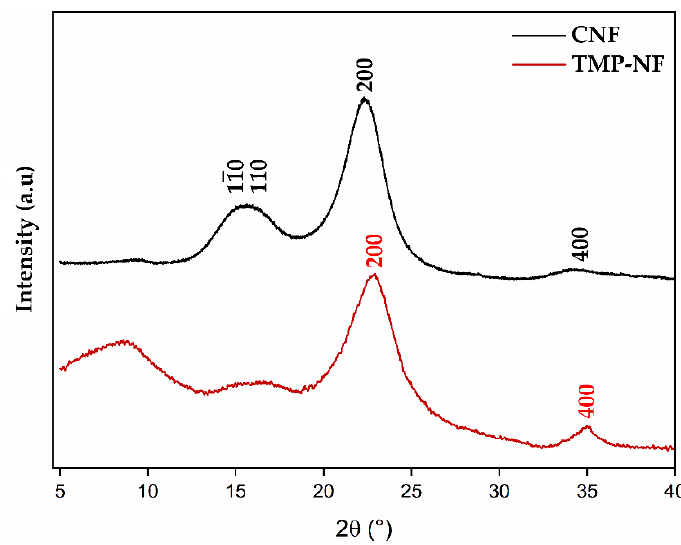
Figure 7. XRD analysis. Diffractogram for the CNF and TMP-NF samples.